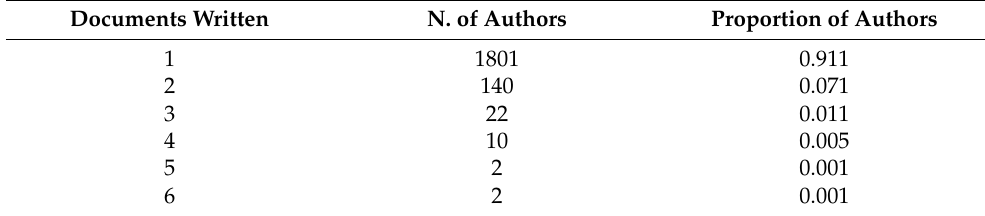
Table 2. Author productivity through Lotka’s Law.